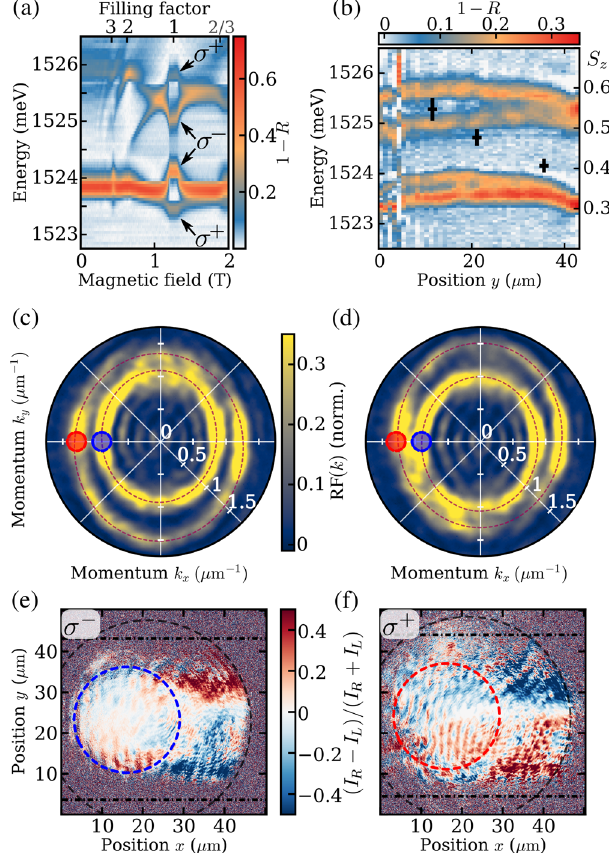
FIG. 4. Spin-selective polariton acceleration. (a) Normalized white-light reflectivity spectra measured at k k ¼ 1 . 2 μ m − 1 as a function of magnetic field. The corresponding Landau level filling factor is determined from an independent magnetotran- sport measurement. (b) Normalized reflectivity spectra at k k ¼ 1 . 2 μ m − 1 and B ¼ 1 . 1 T across the vertical y direction on the Hall bar, with a source-drain bias Δ V R ¼ − 0 . 17 V. Black points indicate the electron spin polarization S z measured at three different positions. (c),(d) Momentum-resolved polariton RF emission under cross-linear polarization at 1523.8 meV ð 813 . 62 nm Þ for (c) Δ V ¼ − 0 . 17 V and (d) Δ V ¼ − 0 . 35 V. R L The red dashed lines are guides to the eye. (e),(f) Normalized difference between two RF images of right-propagating polar- itons acquired with Δ V R ¼ − 0 . 17 V and Δ V L ¼ − 0 . 35 V. (e) Excitation of σ − polaritons at k x ¼ − 0 . 9 μ m − 1 , k y ¼ 0 . (f) Excitation of σ þ polaritons at k x ¼ − 1 . 3 μ m − 1 , k y ¼ 0 . The horizontal dash-dotted lines delimit the width of the Hall bar, the large circle is the field of view of the microscope. The red and blue rings in (c)-(f) show the excitation spots in real and momentum spaces for σ þ and σ − polaritons,